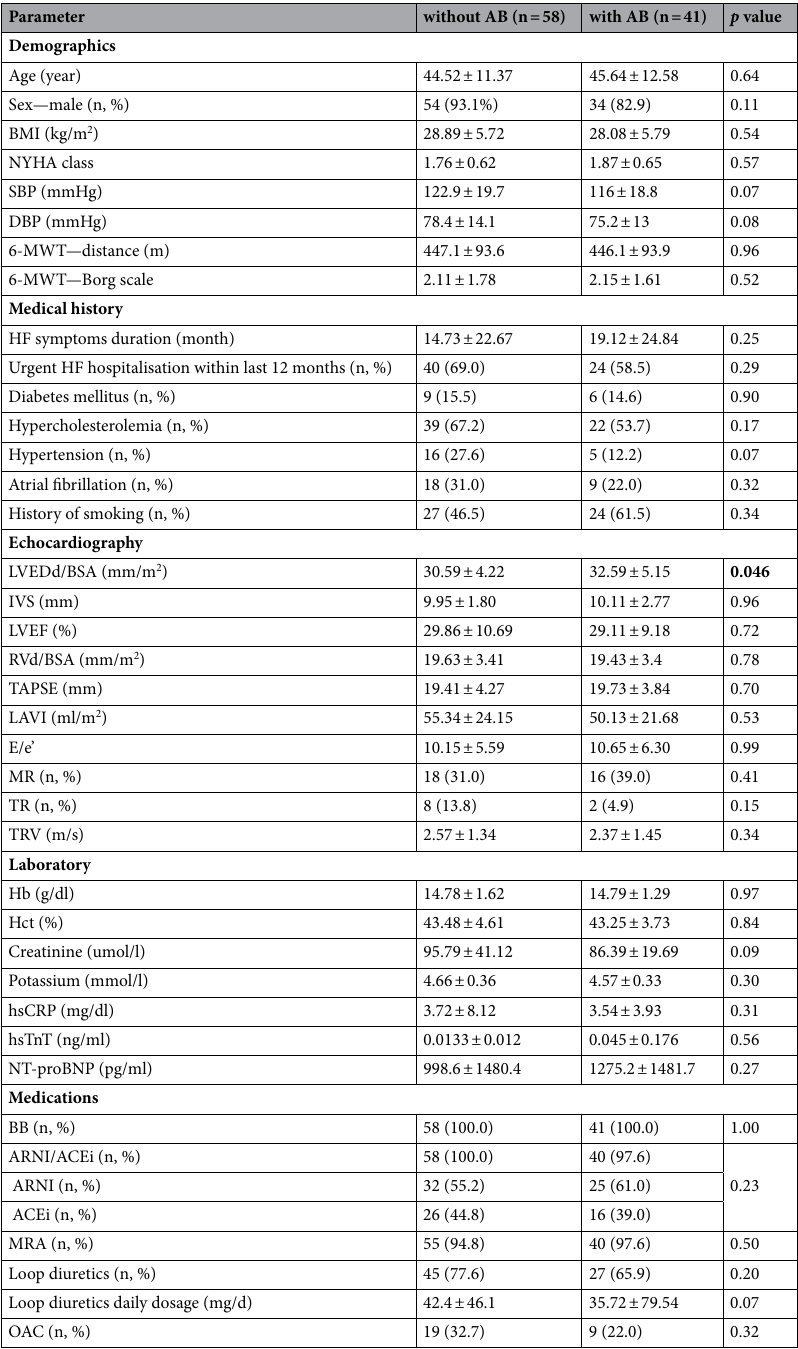
Table 1. Baseline characteristic. Comparison of DCM patients with and without AB. Values are mean ± SD or n (%). AB arrhythmic burden, BMI body mass index, HF heart failure, NYHA New York Heart Association class, SBP/DBP systolic/diastolic blood pressure, 6-MWT 6-min walk test, LVEDd left ventricle end-diastolic diameter, BSA body surface area, LVEF left ventricle ejection fraction, RVd right ventricle basal diameter from apical 4-chamber view, TAPSE tricuspid annular plane systolic excursion, LAVI left atria volume indexed, MR/TR moderate or severe mitral/tricuspid regurgitation, TRV TR peak velocity, Hb haemoglobin, Hct haematocrit, hsCRP high-sensitive C-reactive protein, hsTnT high-sensitive troponin T, NT-proBNP N-terminal pro b-type natriuretic peptide, BB beta-blocker, ARNI angiotensin receptor-neprilysin inhibitor, ACEI angiotensin-converting-enzyme inhibitor, MRA mineralocorticoid receptor antagonist, OAC (VKA and non-VKA) oral